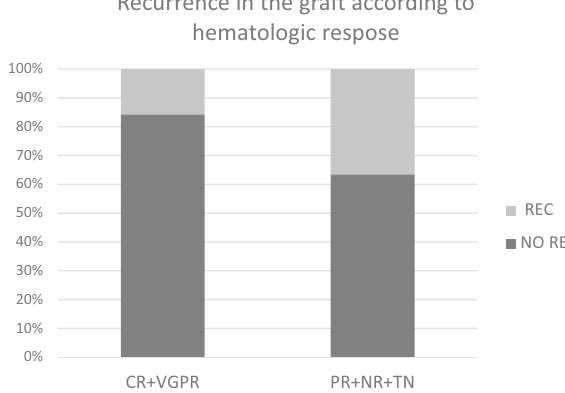
Fig. 3 Disease recurrence in the graft after renal transplantation. AL amyloidosis recurrence in the graft after renal transplantation according to hematologic status at the time of transplantation: CR + VGPR vs. PR + NR + TN (CR complete response, VGPR very good partial response, PR partial response, NR no response, TN treatment